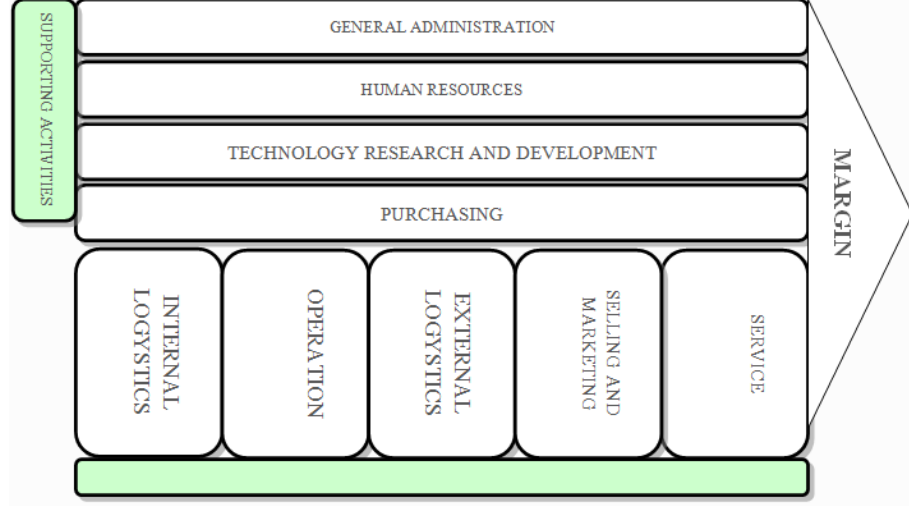
Fig. 1. Generic value chain of